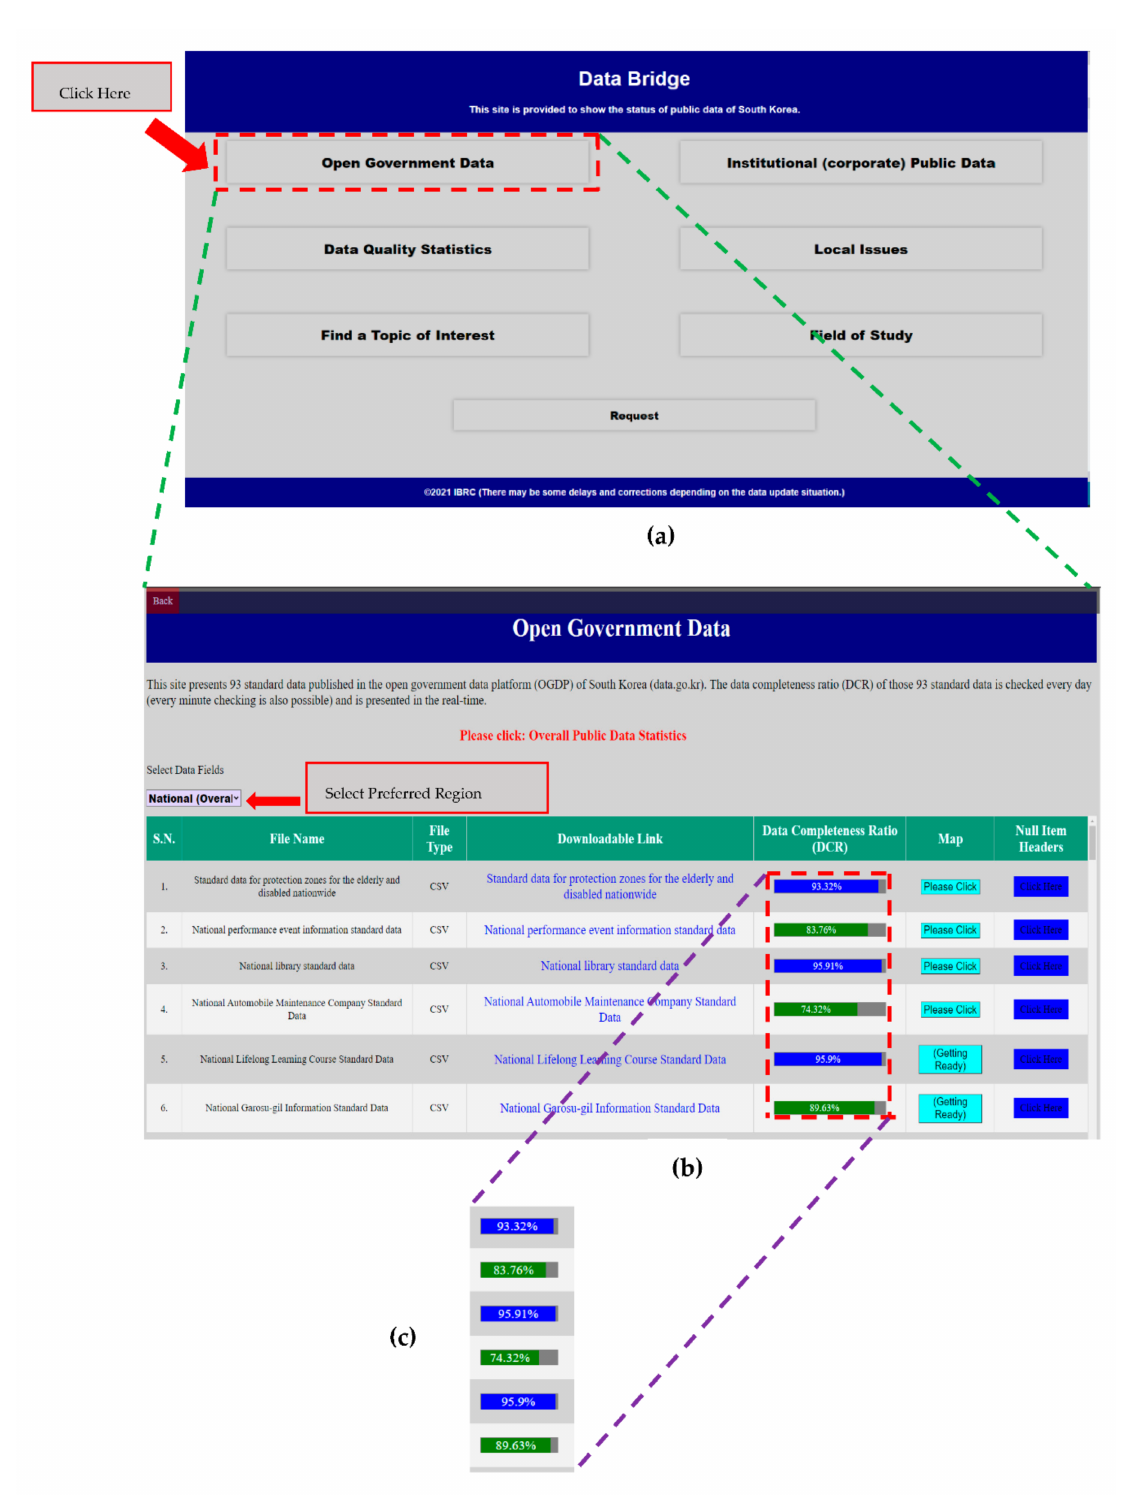
Figure 12. Dashboard under the URL http://cityview.inu.ac.kr (accessed on 9 August 2021), where ( a ) is the dashboard home page, ( b ) is the dashboard showing standard public data information of South Korea, ( c ) is the dashboard showing DCR of the files listed there for National